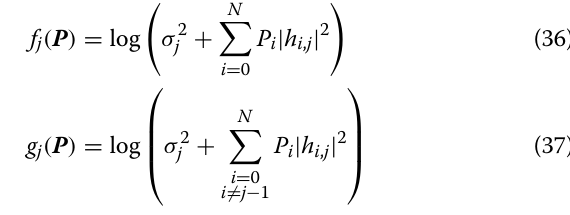
Algorithm 1 solves the approximate convex problem (42)